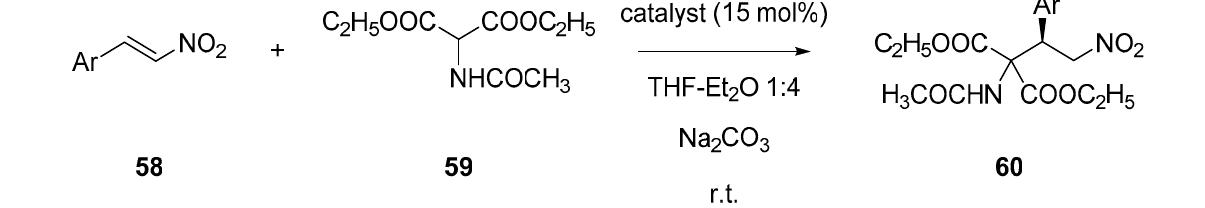
Table 4. Effect of crown ethers in the Michael addition of diethyl acetamidomalonate ( 59 ) to nitrostyrenes ( 58